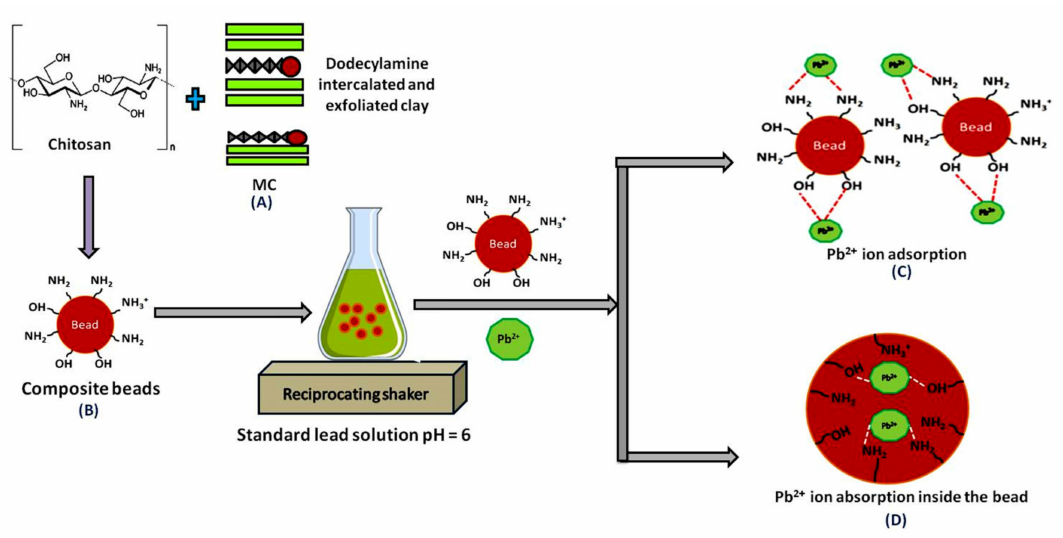
Figure 9. Proposed adsorption mechanism of Pb (II) on composite beads at pH = 6. ( A ) Dodecylamine molecules are intercalated or exfoliated on or within the clay structure and help to attach chitosan molecules to the clay. ( B ) Structure of bead showing -NH 2 from chitosan and -OH from both chitosan and clay. ( C ) Adsorption of Pb 2 + on bead surface interacting with -NH 2 and –OH. ( D ) Adsorption of Pb 2 + within interior of